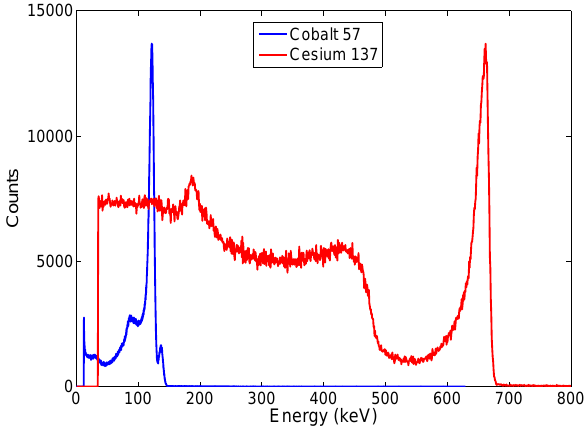
Figure 9. 137 Cs and 57 Co emission spectra as measured by the detector and the electronic mounted on the UAV in an indoor laboratory